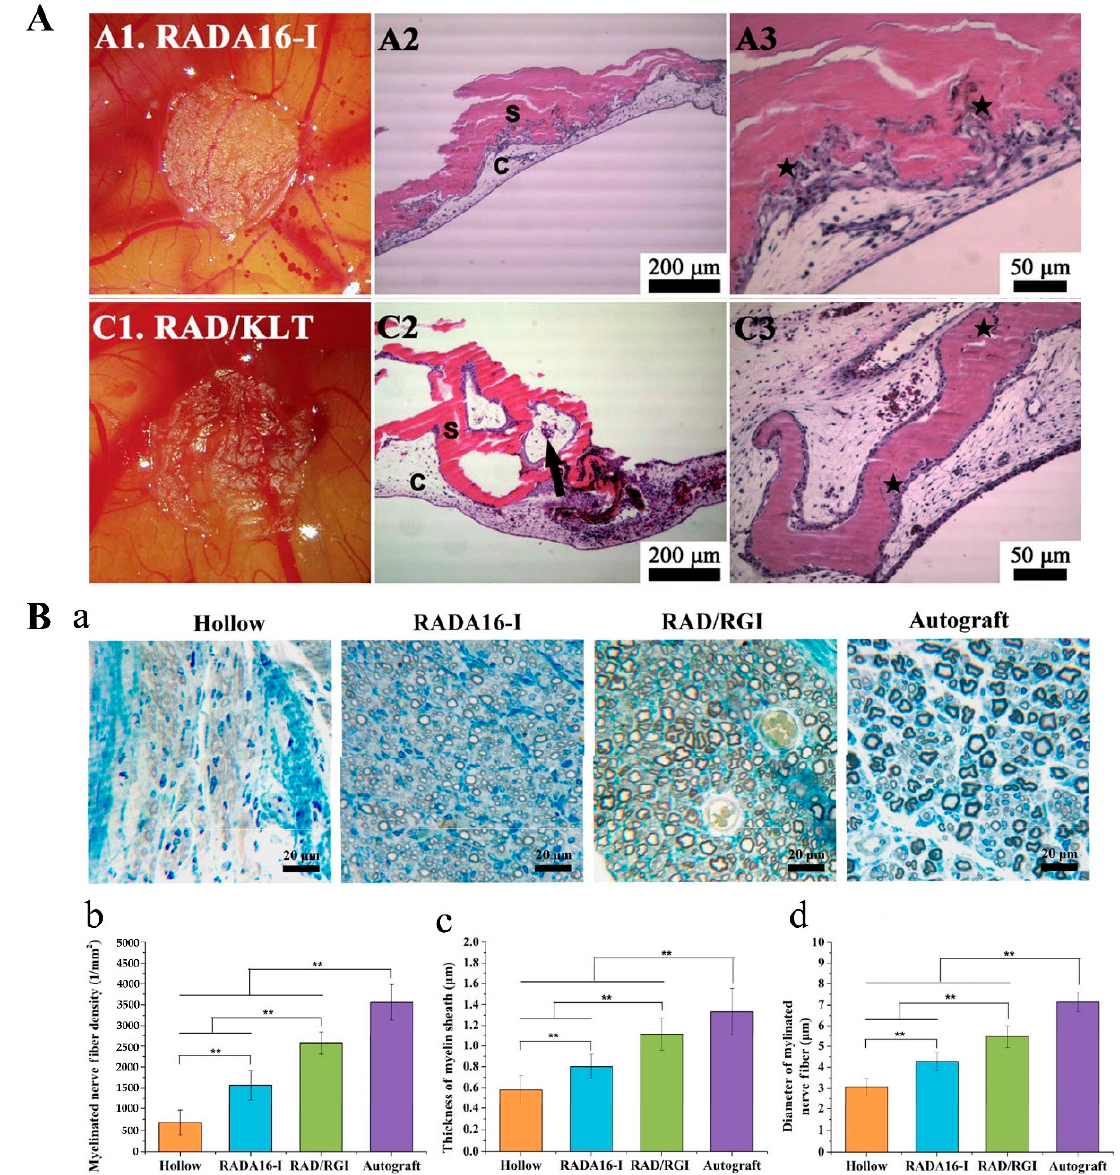
Figure 4. Promoting positive factors. ( A ) Gross morphology and H&E staining of CAM with different scaffold hydrogels at day four after implantation. S: implanted hydrogels; C: the CAM. Black arrows indicate new capillary vessels. (cid:70) indicates that epithelial cells from the ectoderm of CAM proliferate and migrate into the implanted hydrogels. Adapted with permission from Ref. [57]. Copyright 2012 Nanoscale. ( B ) Morphometric analysis of the middle of the implants 12 weeks after surgery. Hollow: hollow chitosan nerve conduit group. Autograft: autologous nerve graft-transplanted group. ( a ) Toluidine blue staining of semi-thin sections. ( b ) The density of myelinated axons is expressed as the number of myelinated axons per square millimeter (n, 1/mm 2 ). ( c ) The diameters of myelinated axons. ( d ) The thickness of myelin sheath. ** p < 0.01 ( n = 3). Adapted with permission from Ref. [40]. Copyright 2018 Nano Research.